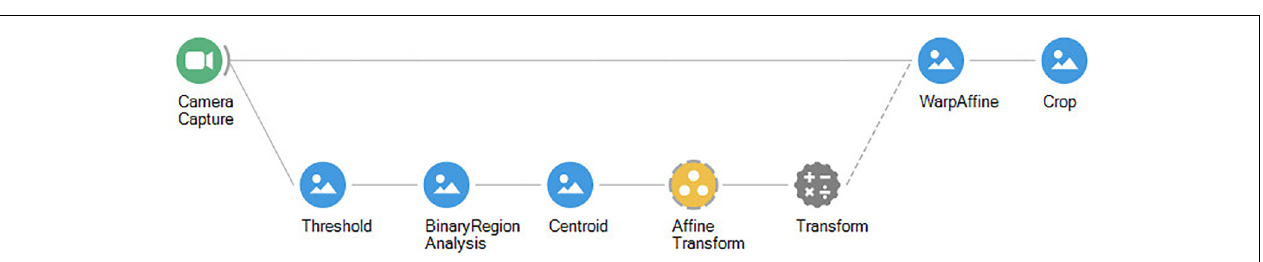
FIGURE 5 | Bonsai workflow for dynamic cropping of a region of interest around the center of the